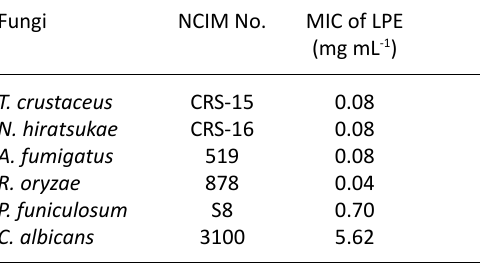
Table 3. MIC values of lipopeptides extract (LPE) from